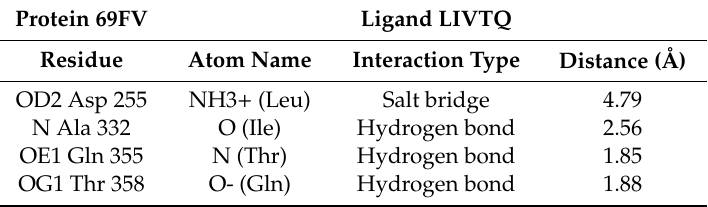
Table 3. LIVTQ docking